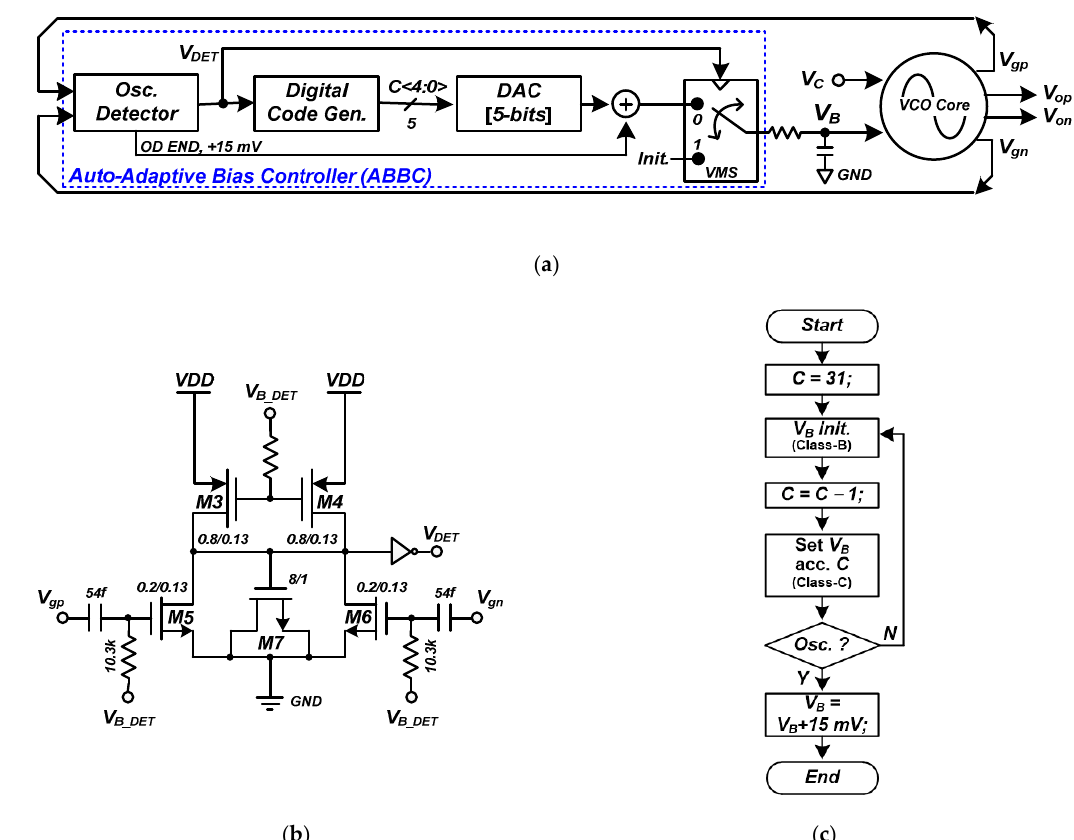
Figure 4. This figure is ( a ) block diagram of proposed ABBC and class-C VCO, ( b ) is a circuit diagram of oscillation detector (OD).and ( c ) the operation is simply expressed in a flow chart.